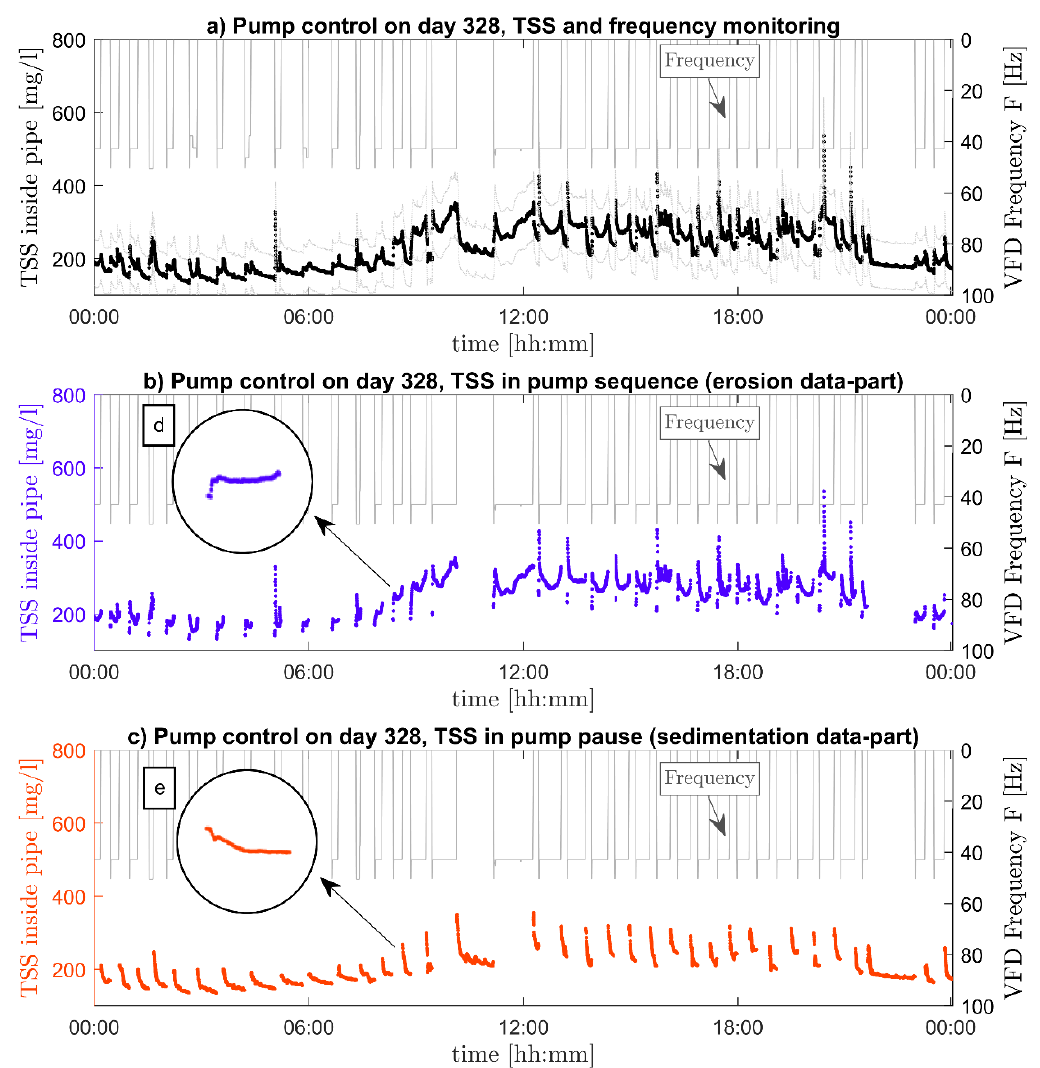
Figure 3. Data separation scheme: monitored TSS data ( a ) is split into an erosion- ( b ) and a sedimentation part ( c ). Frequency data from both VFD (for P1 and P2) is used as decision criterion for data separation (if VFD1 and VFD2 = 0, then settling sequence, else erosion sequence). The separation into single erosion ( d ) and sedimentation events ( e ) is based on a time difference between each value. If the time difference is larger the logging interval of 5 s (see Table 1), a single event is detected and separated.